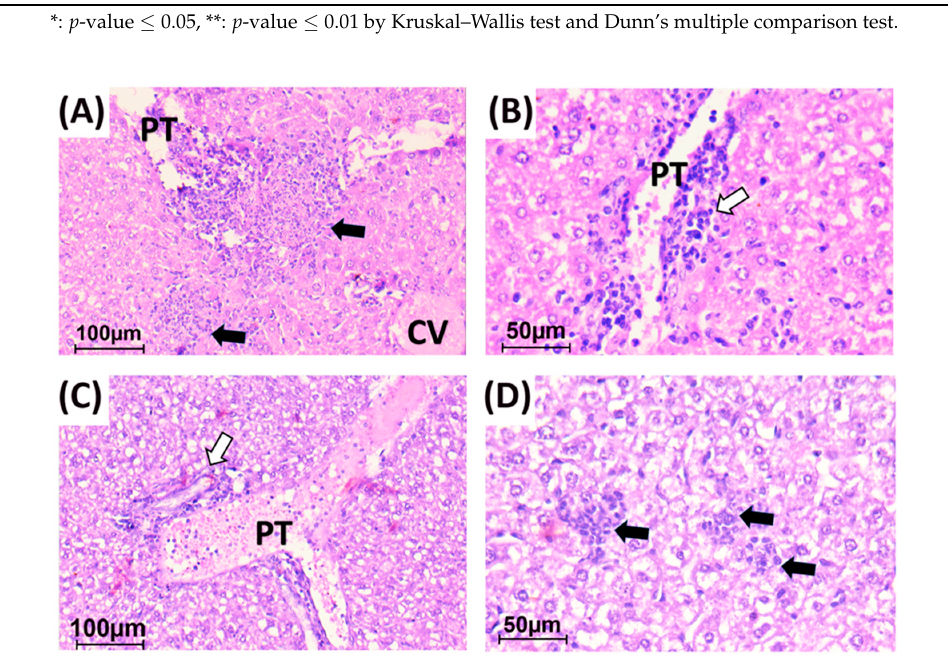
Figure 7. Histologic findings in H&E-stained liver sections in the studied groups: Saline: ( A ) Liver tissue showing mild distortion of lobular architecture. Portal tract (PT) exhibiting severe congestion of portal vessels and severe inflammation. Central veins (CV) are congested as well. Multiple large